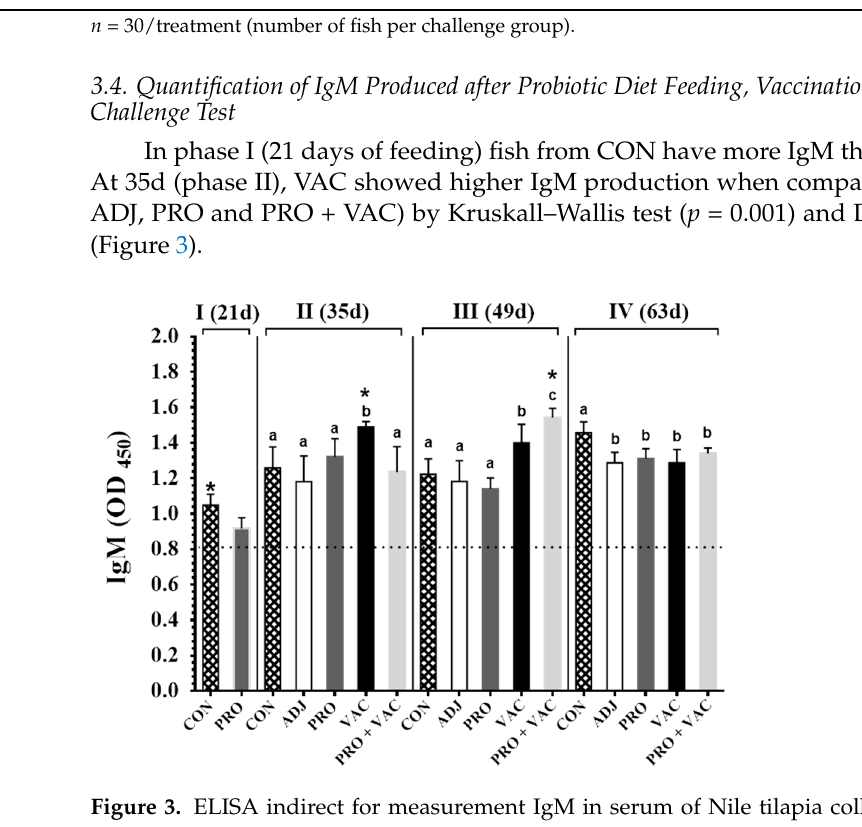
n = 30/treatment (number of fish per challenge group).